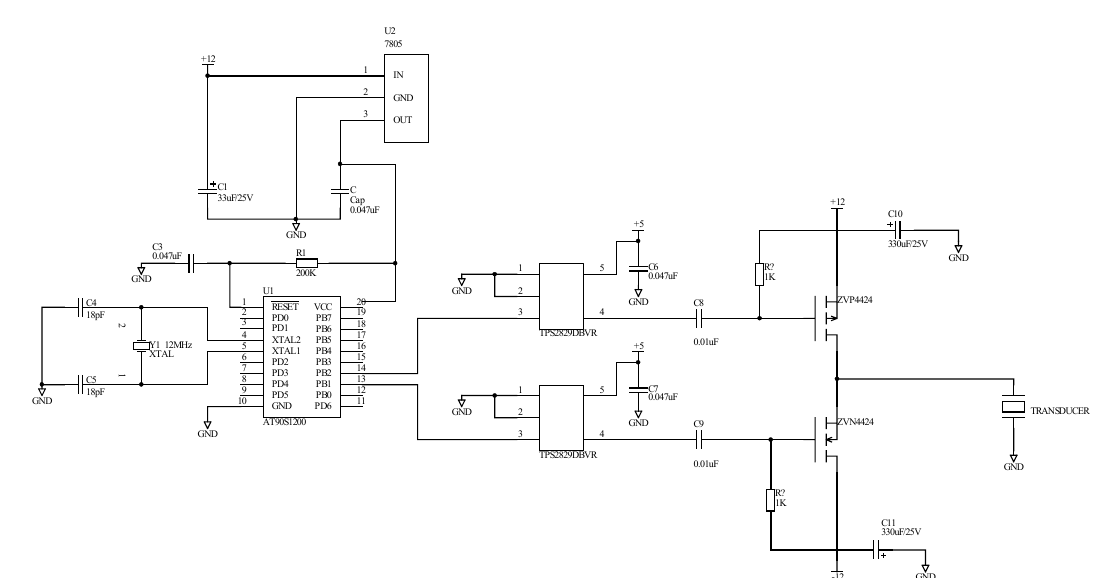
Figure 8a. The transmitter circuit that converts digital signals from the main controller to voltage pulses for the transducer.